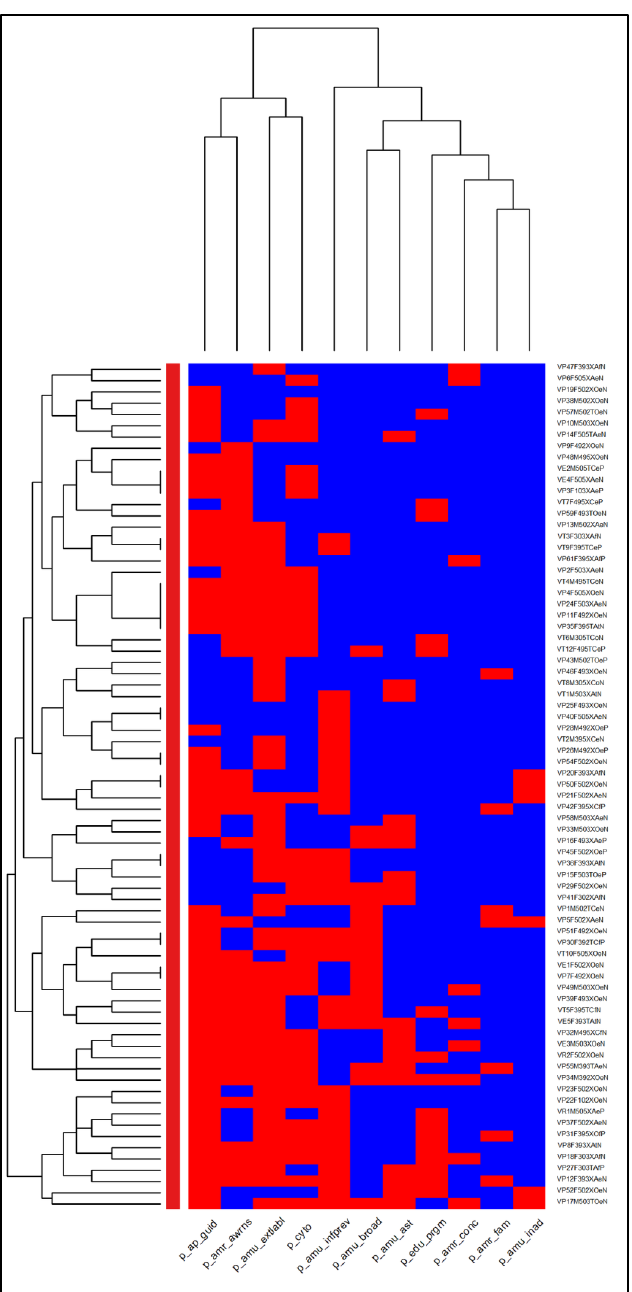
Figure 1. Hierarchical clustering dendrogram of small animal veterinarians’ awareness of AMR and belief of practices that contribute to the selection of antimicrobial resistance. Red color, no (0); blue color, yes (1). p_ap_guid: antimicrobial prescription guideline in the practice facility; p_amr_awrns: awareness of local antimicrobial resistance profile; p_amu_extlabl: prescription of antibiotics extra-